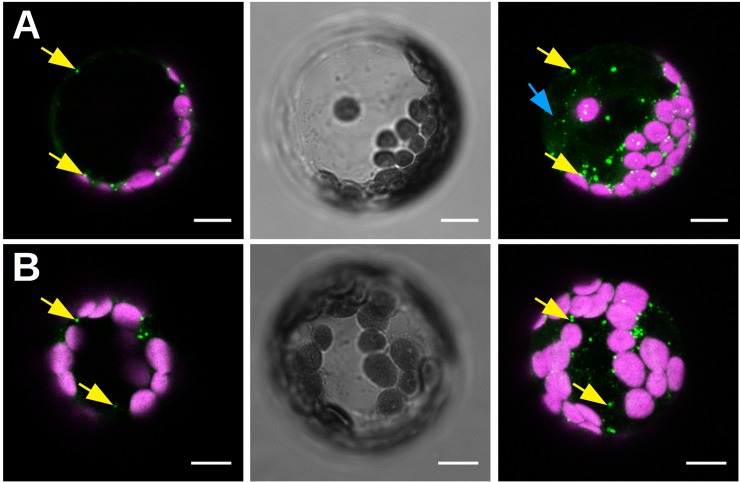
Observation of CaMV11P6-transfected A. thaliana GFP1-10 protoplasts.Protoplasts were transfected with infectious CaMV11P6 plasmid (A) or with CaMV11P6 virus particles (B), and observed 15 h later by confocal fluorescence microscopy. Protoplasts display fluorescent 11P6 foci (green spots indicated by yellow arrows) and weak cytosolic 11P6 label (blue arrow). The images shown in (A) or (B) are from the same protoplast. The left panels present optical single sections, the right panels maximum projections, and the middle panels bright field illumination images. Chloroplasts are presented in magenta. Scale bars in all panels represent 10 μm.